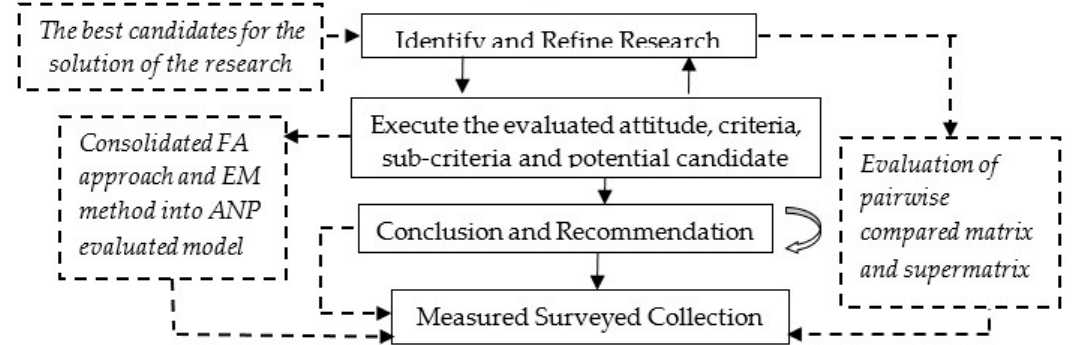
Figure 4. The main evaluated framework of analytical network process (ANP) model.